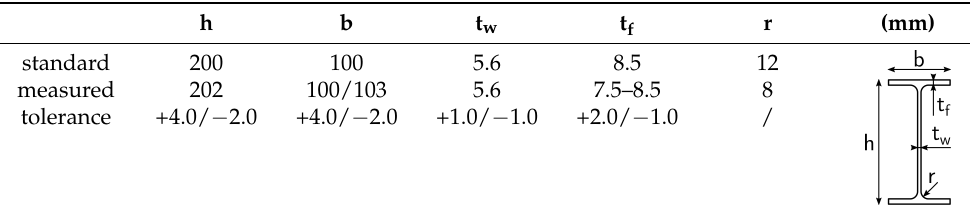
Table 2. Dimensions of a standard IPE 200 profile compared with the real dimensions of the used profile and the tolerances given by DIN EN 10034.